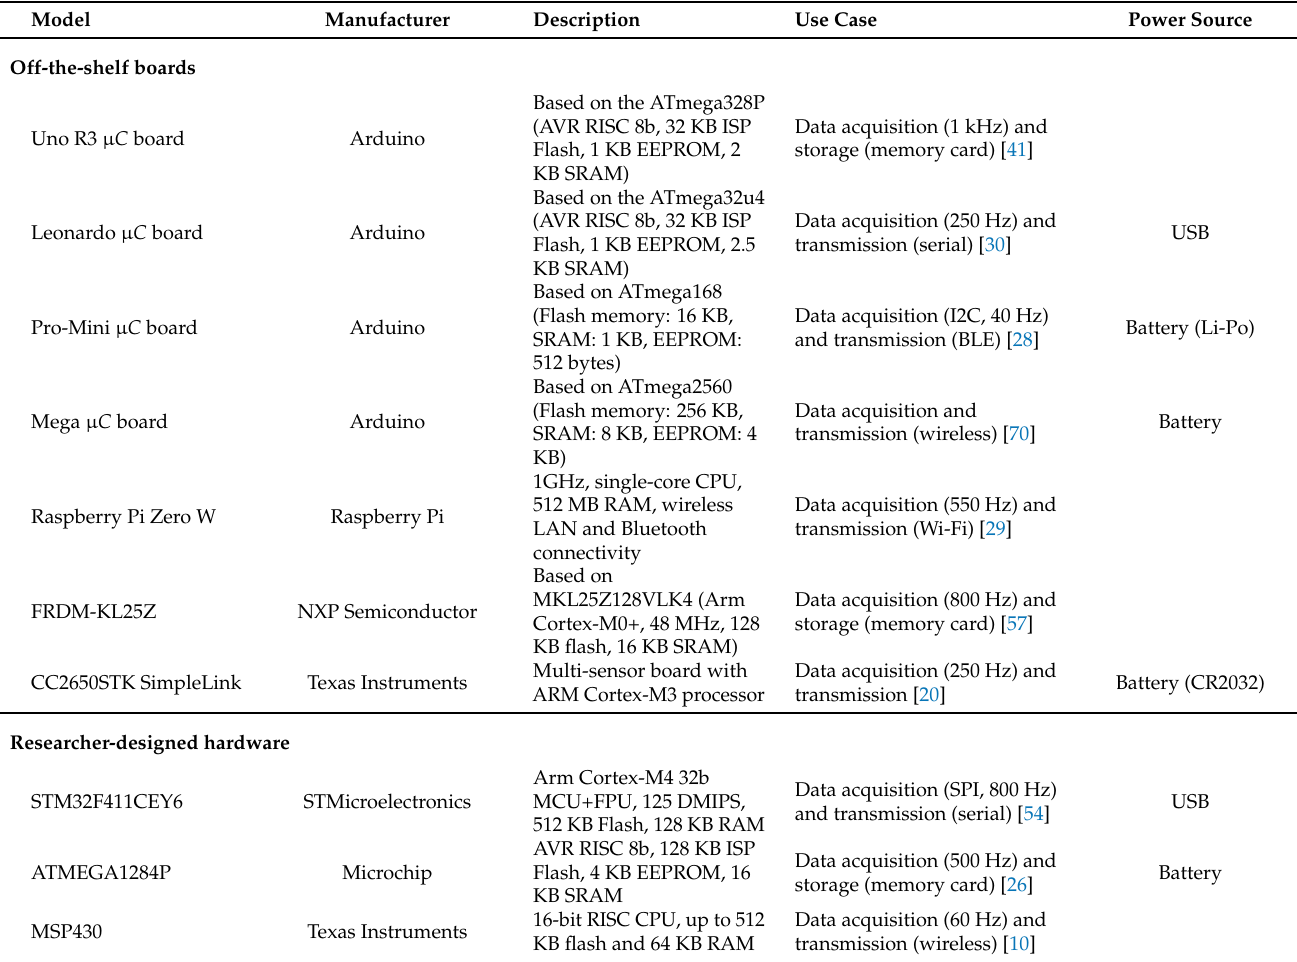
Table 6. On-body processor hardware used in the referenced studies along with the use case and how the unit was powered. Model Manufacturer Description Use Case Power Source Off-the-shelf